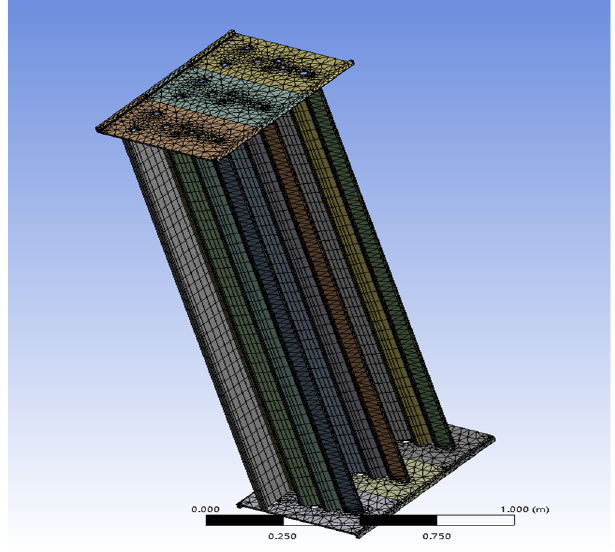
Figure 14. The meshing of the model.